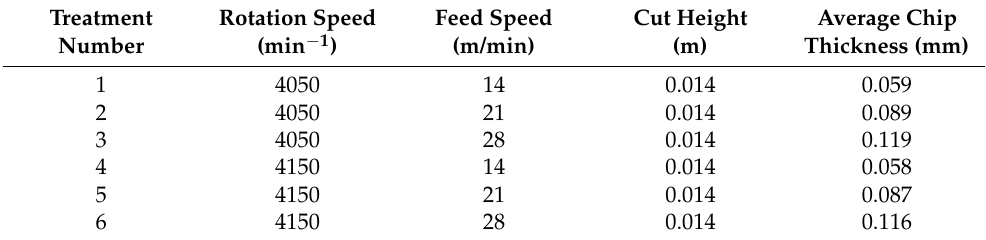
Table 3. Rotation speed, feed speed and cut height for the 6 cutting treatments. Corresponding average chip thickness is also listed.